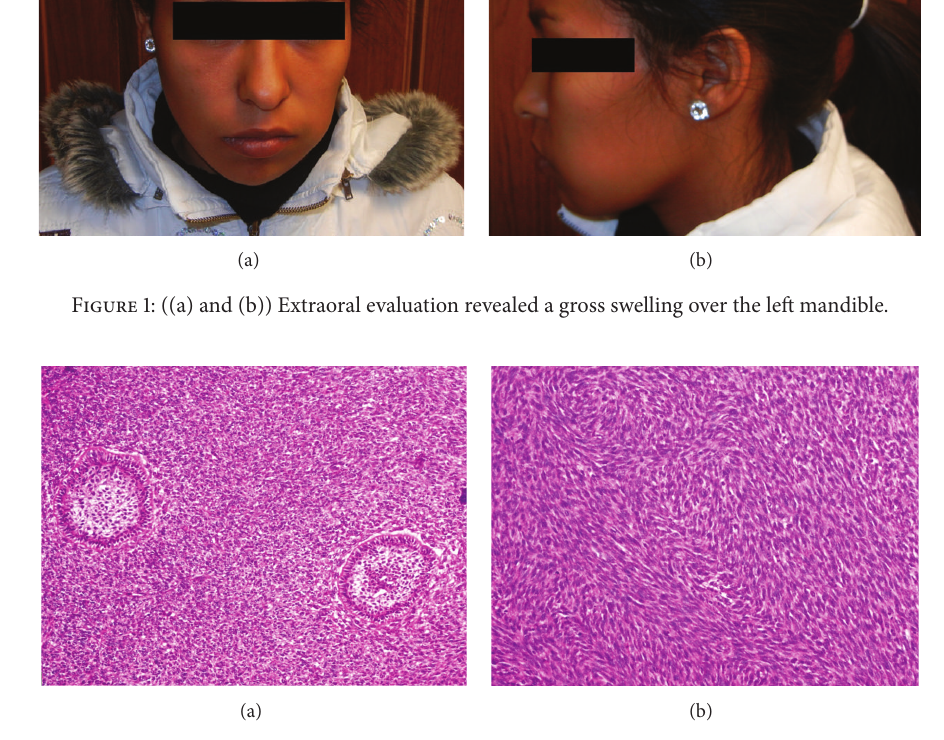
Figure 2: (a) Biphasic tumor composed of islands of benign odontogenic epithelium and an abundant malignant mesenchymal component. H&E stain, × 50. (b) The malignant mesenchymal component consists of plump and spindle stromal cells which show mild to moderate cytologic atypia and numerous mitotic figures arranged in storiform and herringbone fashion. H&E stain, ×